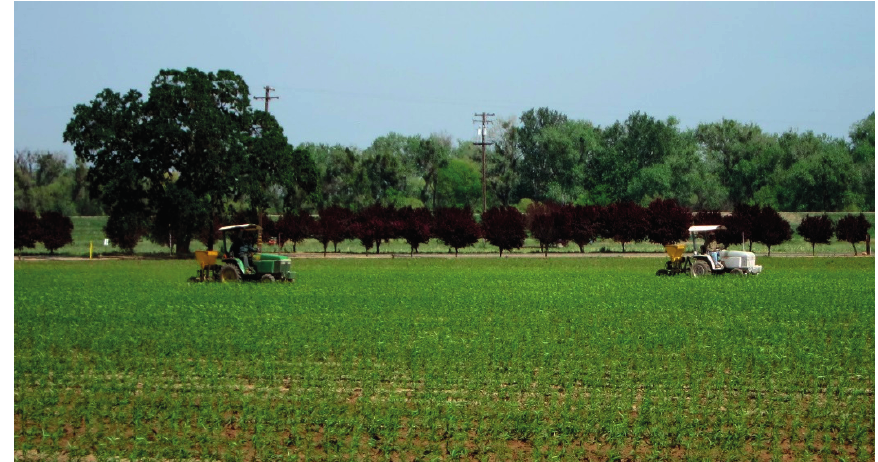
Figure 1. Tractors are performing the fertilization step at the same time as the counting, at Sierra Gold Nurseries, CA,